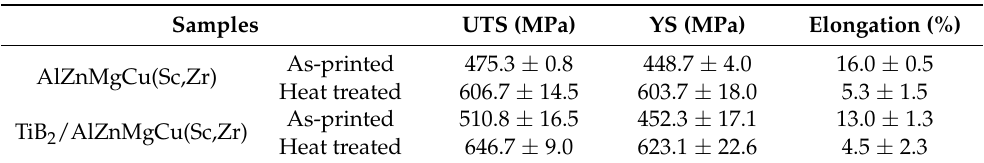
Table 3. Comparison of mechanical properties of AlZnMgCu(Sc,Zr) alloy and TiB 2 /AlZnMgCu(Sc,Zr) composite before and after heat treatment.